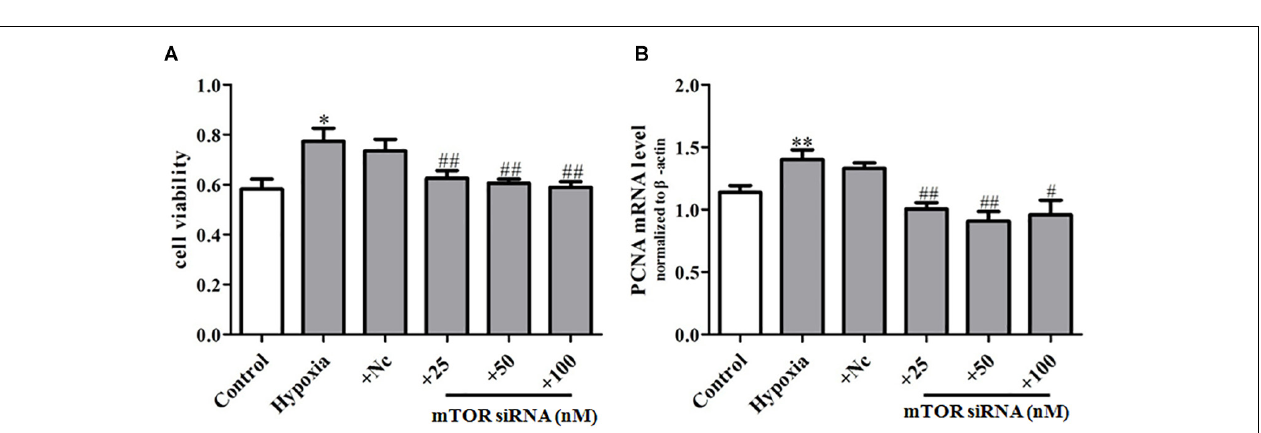
FIGURE 7 | mTOR siRNA can inhibit hypoxia-induced PASMC proliferation. (A) Proliferation of PASMCs was measured by CCK8 assay. (B) The mRNA expression of PCNA was determined by qPCR. Control: cells were treated with 21% O 2 for 48 h; hypoxia: cells were treated with 3% O 2 for 48 h; + NC: cells were transfected with negative control 50 nM for 4 h before stimulation with hypoxia for 48 h; + si mTOR: cells were transfected with 25, 50, and 100 nM mTOR siRNA for 4 h before stimulation with hypoxia for 48 h, respectively. Data represent mean ± SEM. n = 3. ∗ P < 0.05 vs. control, ∗∗ P < 0.01 vs. control, # P < 0 . 01 vs. hypoxia, ## P < 0.05 vs.